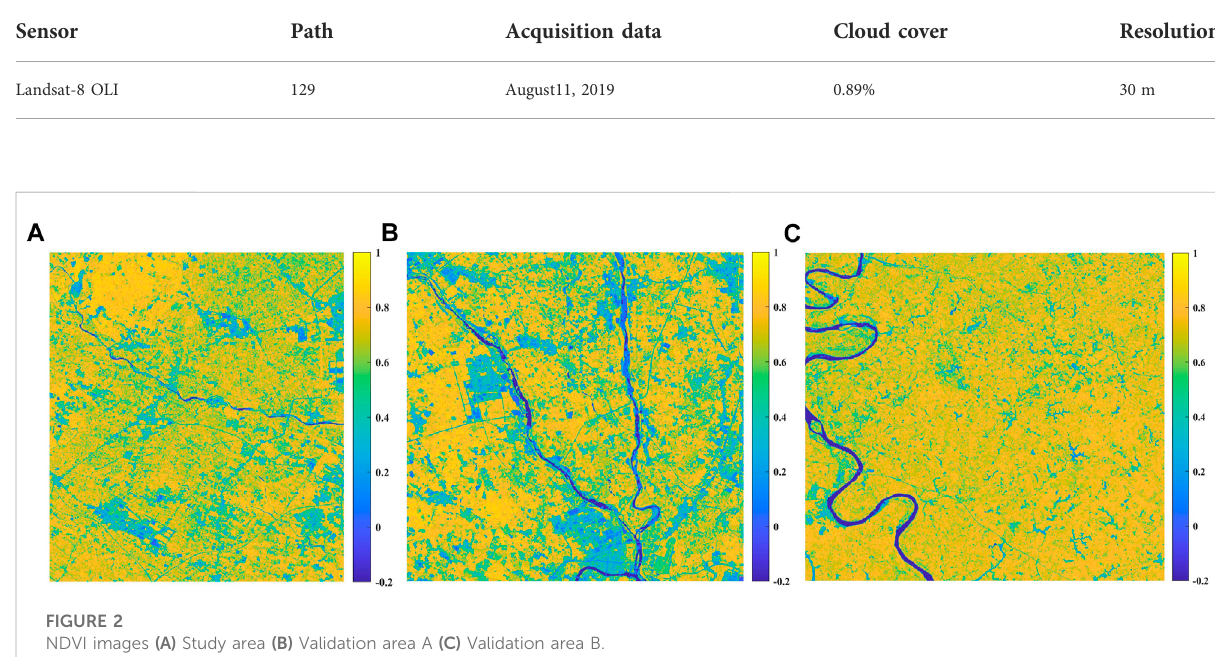
TABLE 1 Landsat-8 image.